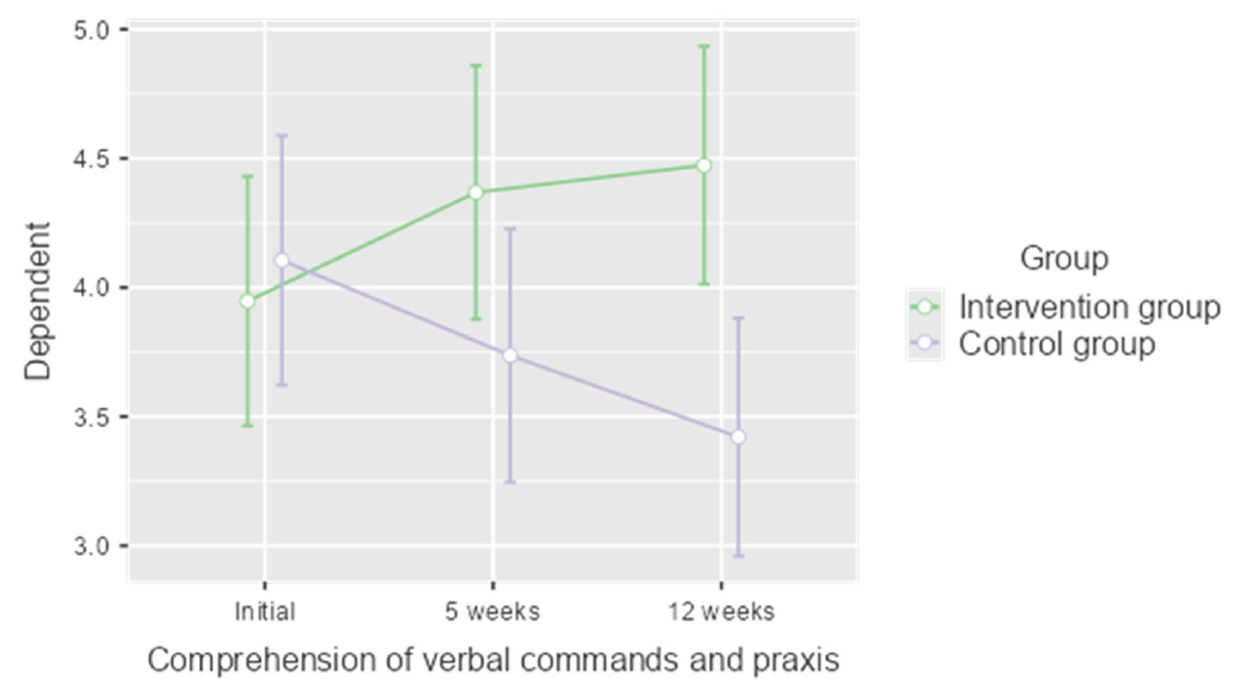
Figure 2. Results of the analysis of the comprehension of verbal commands and praxis dimension of the Lobo Mini Cognitive Test.